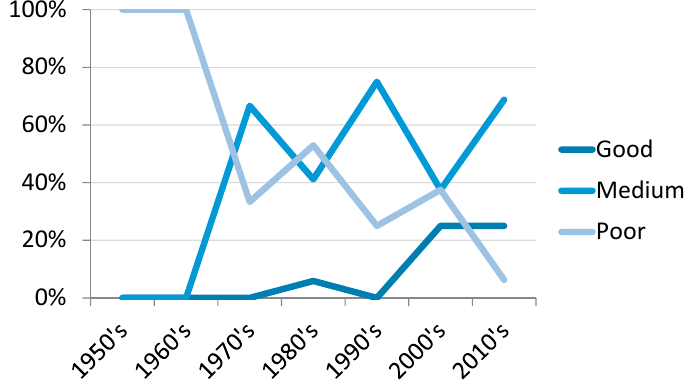
Figure 2. Percentage of total studies per decade categorised as good, medium or poor quality based on the criteria set out by Alonso et al. [24]. Sixteen pathogens, or genera of pathogens, were identified: thirteen in camel hosts, four in ticks retrieved from camels, and two camel-specific strains of pathogen identified in humans (Table 3). Eight viruses, five bacteria, one protozoa, one fungus and one endoparasite were identified. The largest number of papers ( n = 29, 39.2%) dealt with trypanosome species, with the next most frequently reported pathogens being Echinococcus spp. ( n = 9, 12.2%) and Brucella spp. ( n = 7, 9.5%). Five studies were published before 1980, with between 16 and 20 studies published in each decade